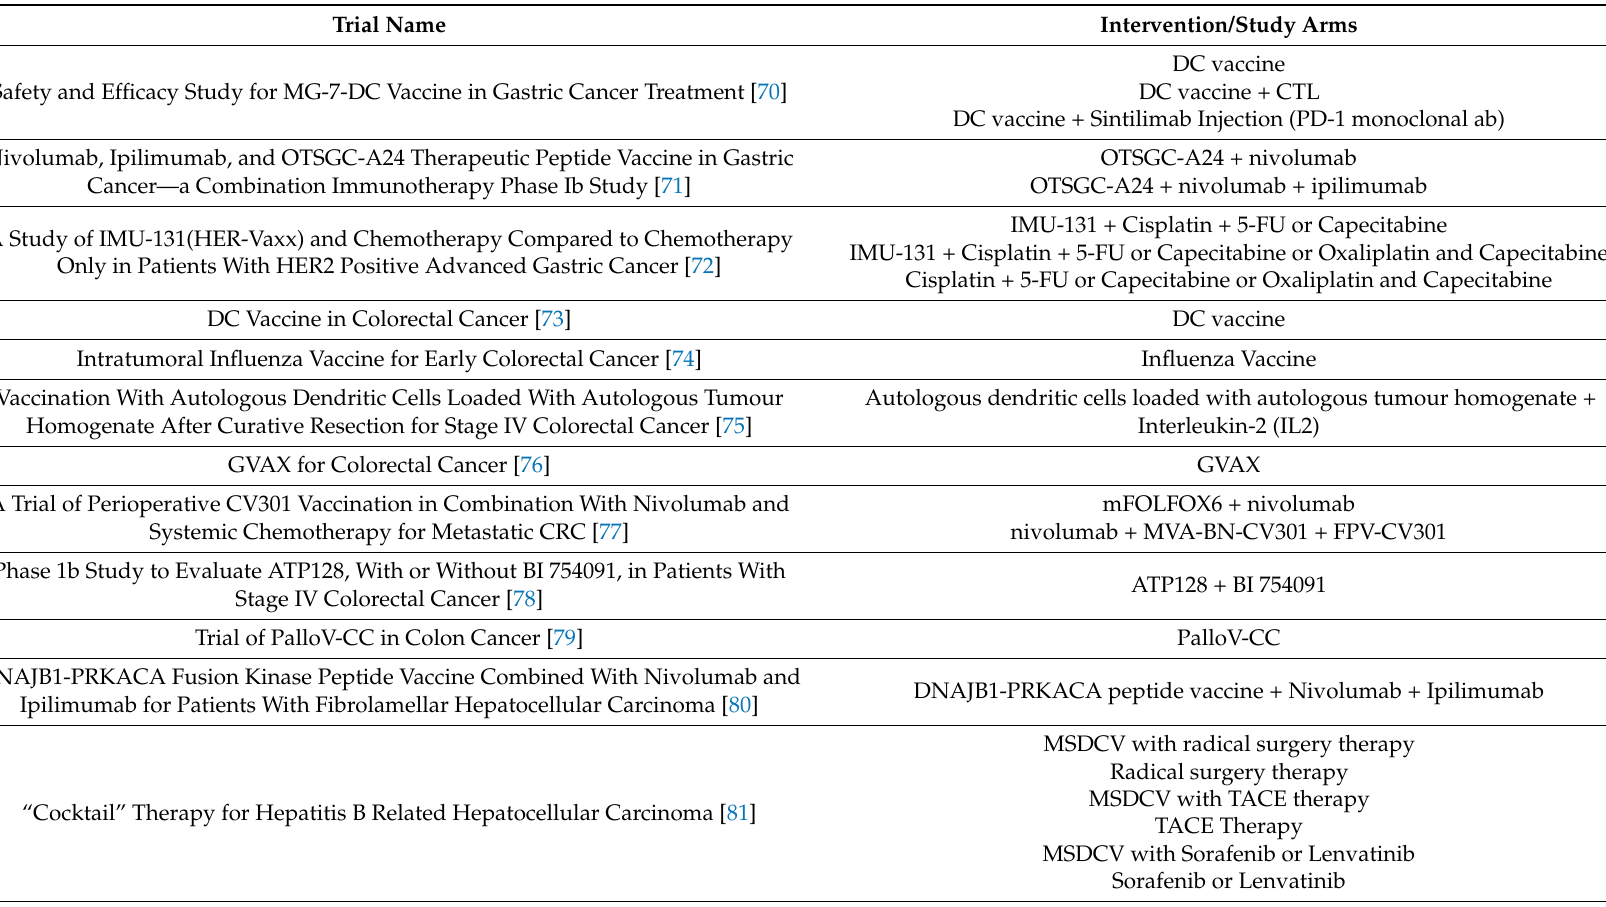
Table 2. Current recruiting clinical trials for cancer vaccines in GI